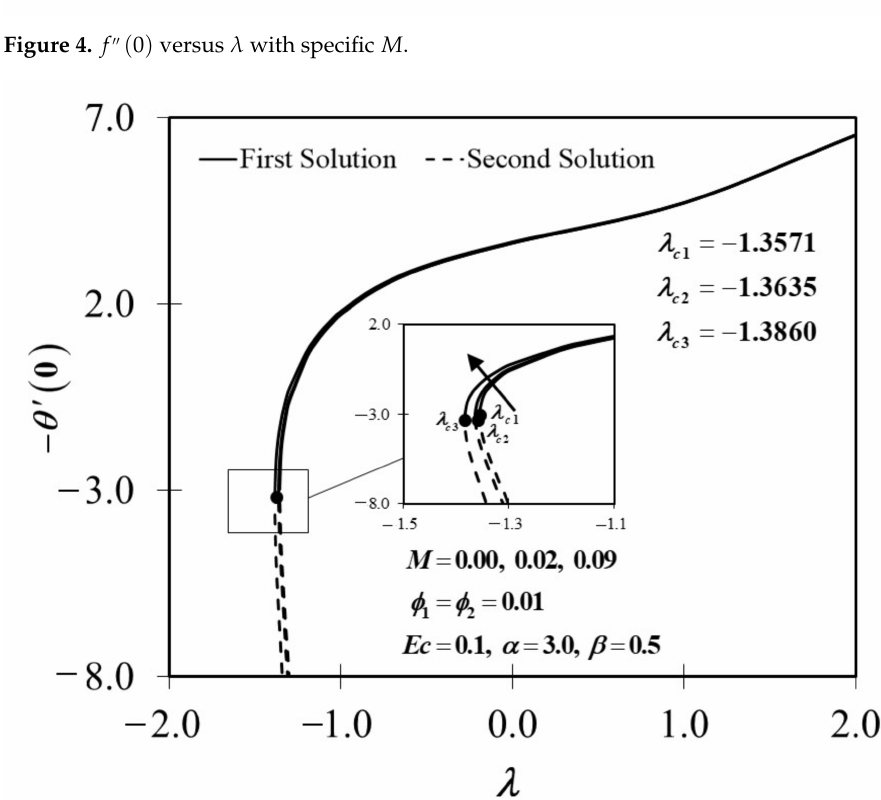
Figure 5. − θ (cid:48) ( 0 ) versus λ with specific M